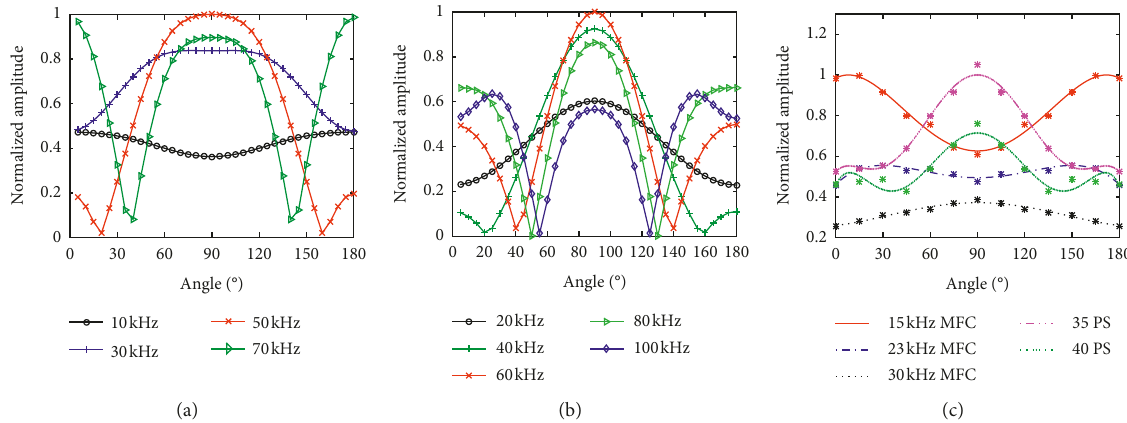
Figure 9: Theoretical and experimental directivity of MFC and piezoelectric sheet: (a) theoretical directivity of MFC; (b) theoretical directivity of the piezoelectric sheet; (c) experimental directivity.